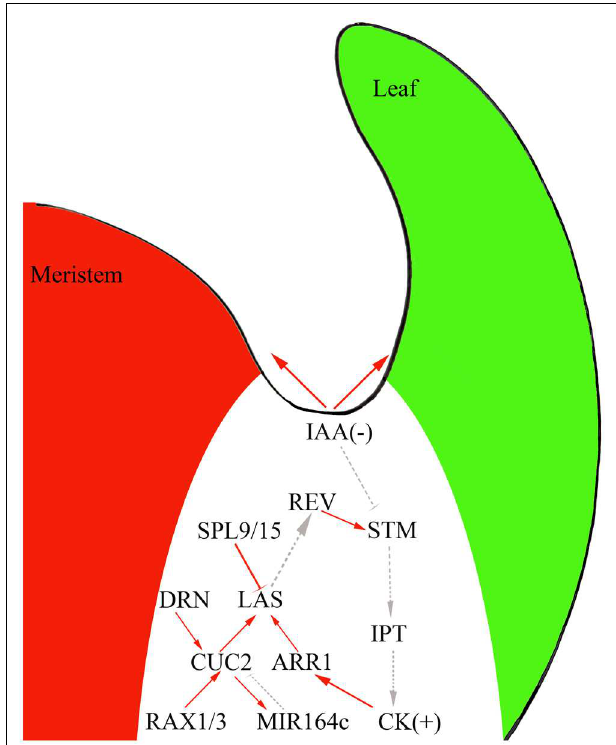
FIGURE 2 | The interplay of phytohormones and transcription factors (TFs) to control AM initiation in the boundary domain. Red solid line, direct interaction; gray dotted line, genetic interaction; arrow, activation effect; bar, repressive